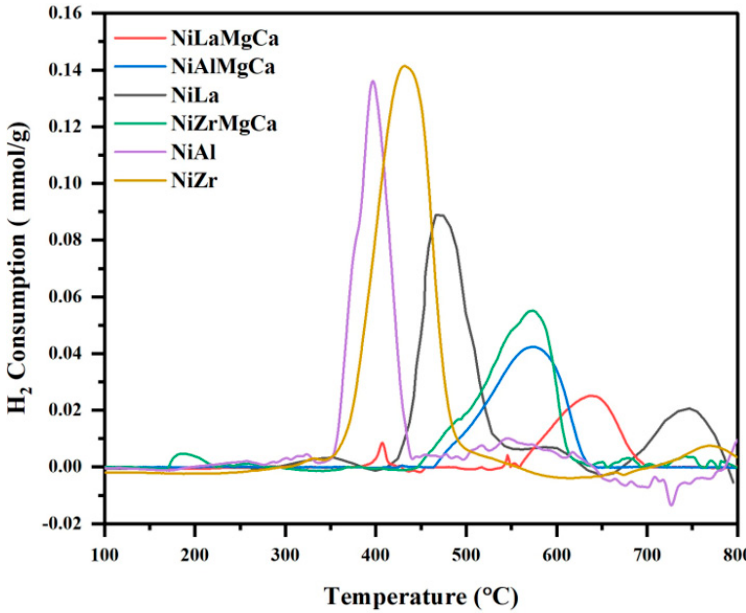
Figure 2. H 2 -TPR profiles of the calcined catalyst. Figure 2. H 2 ‑TPR profiles of the calcined